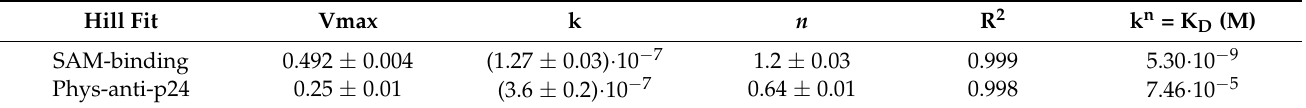
The parameters obtained from the Hill fitting are reported along with their standard error for both immobilization